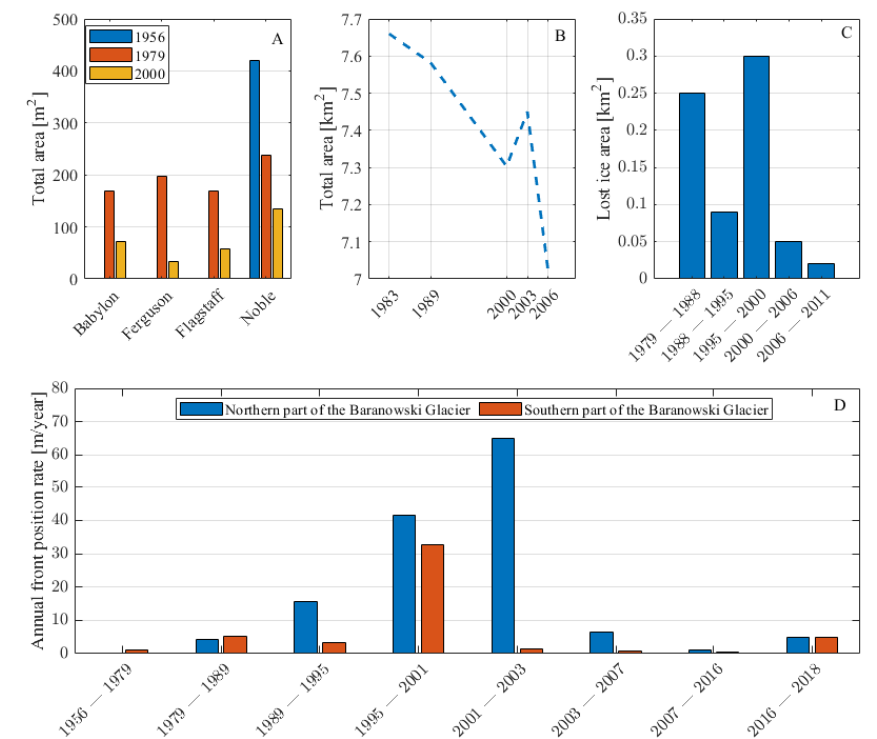
Figure 13. ( A ) Areas of the four cirque glaciers studied on the Keller Peninsula in 1959 (only for Noble Glacier), 1979 and 2000 [67]. ( B ) Frontal retreat of the Bellingshausen Dome between 1989 and 2006 [70]; ( C ) The total area and retreat rate of Wanda Glacier from 1989 – 2011 [71]. ( D ) Multiyear frontal fluctuation rates of Baranowski Glacier (1956 – 2018) [69].